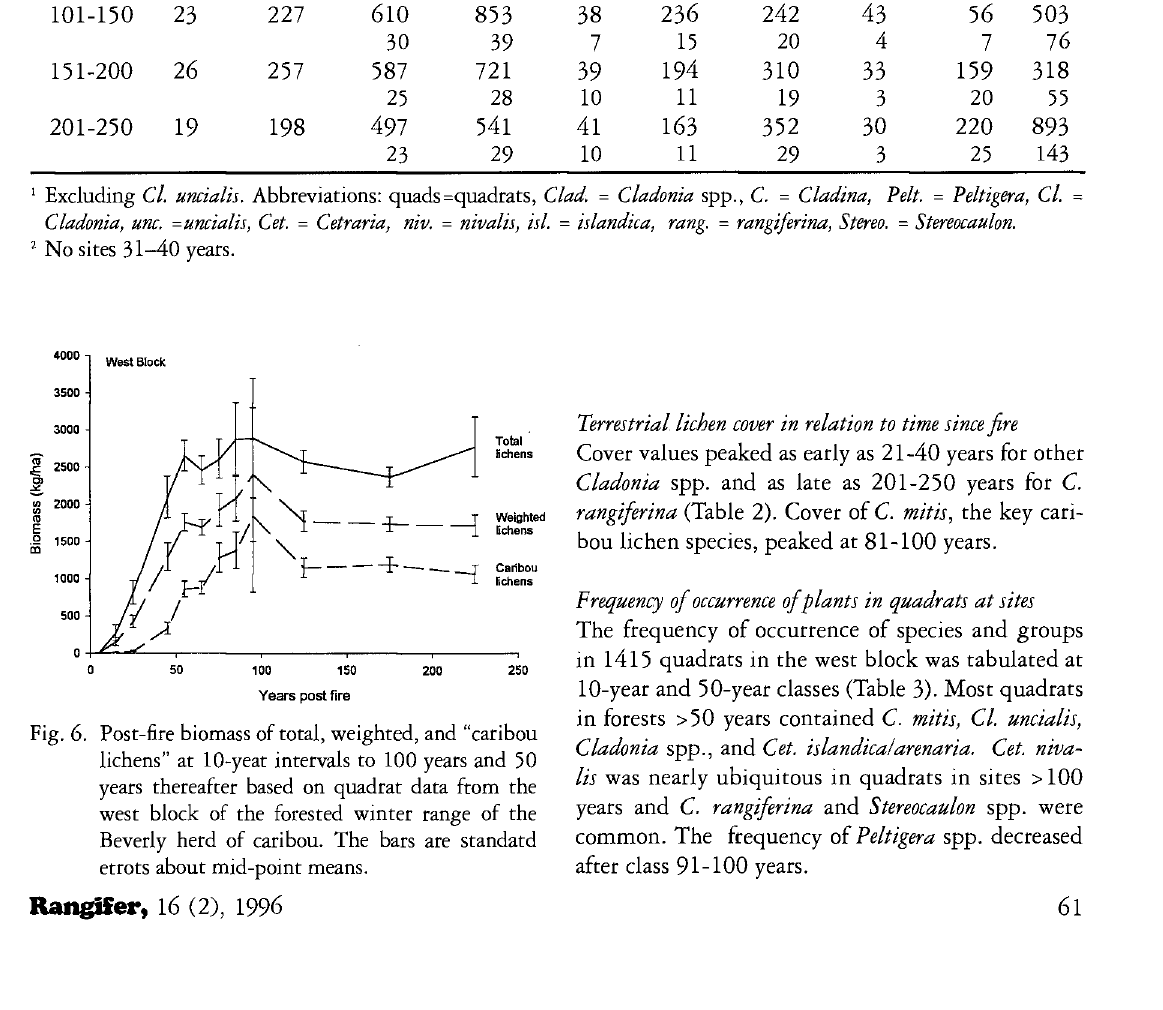
Fig. 6. Post-fire biomass of total, weighted, and "caribou lichens" at 10-yeat intervals to 100 years and 50 years thereafter based on quadrat data ftom the west block of the forested winter range of the Beverly herd of caribou. The bars are standatd etfots about mid-point